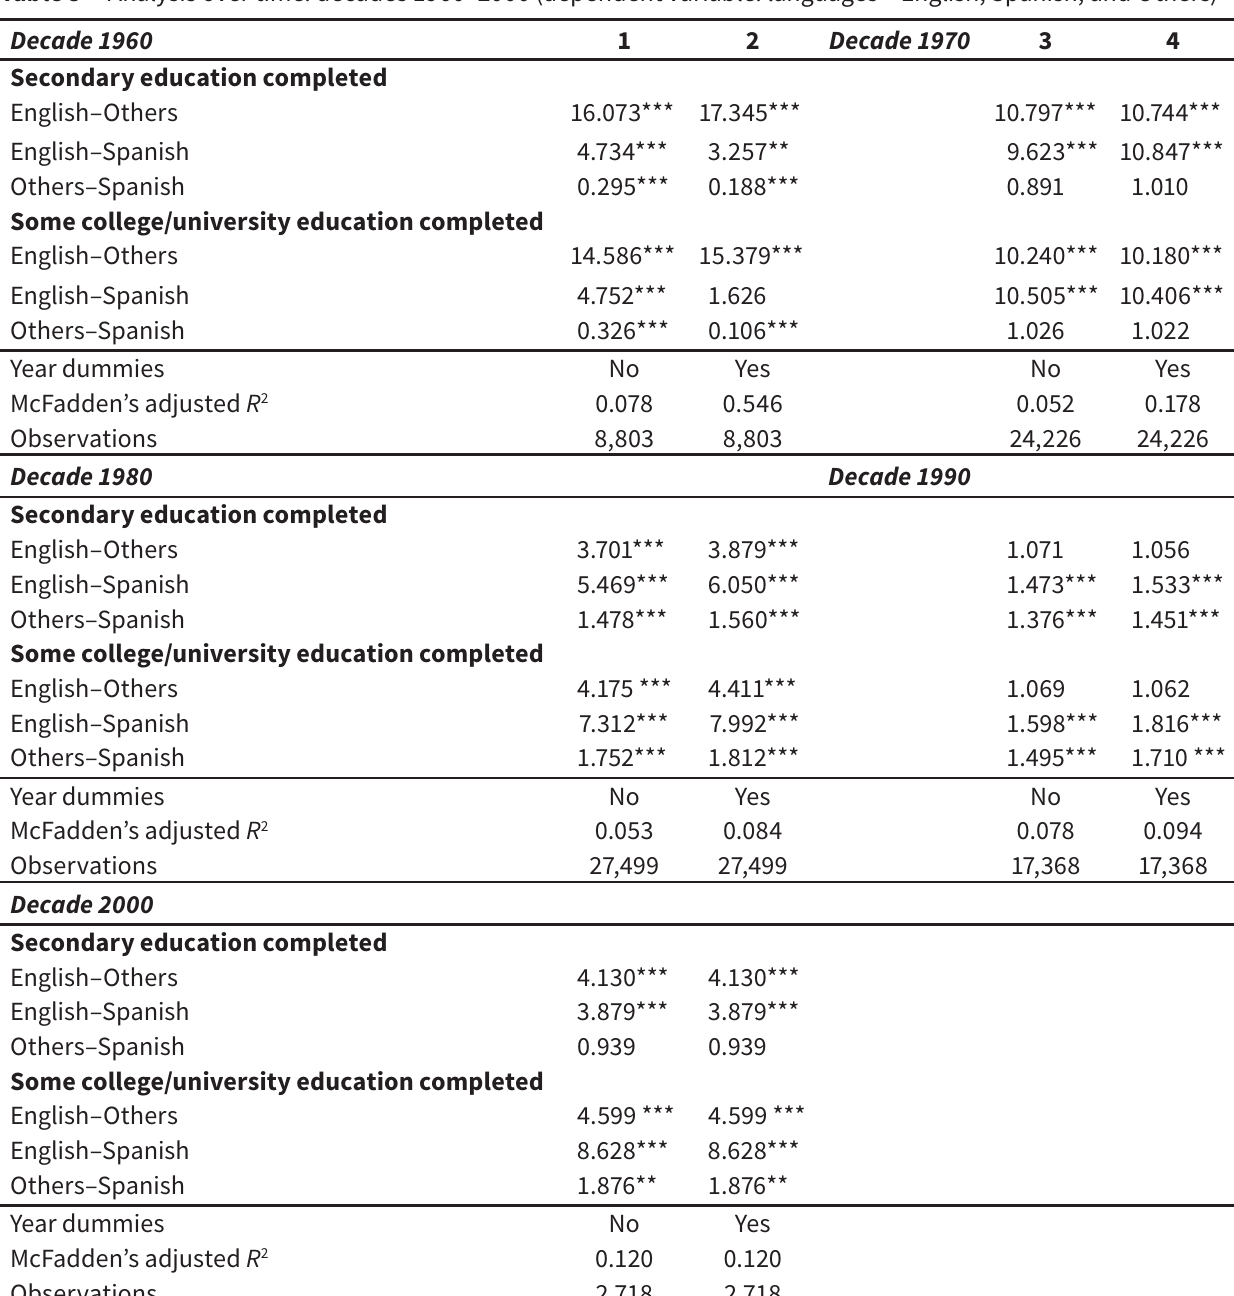
the destination countries. Languages are classified into the following categories: English, Spanish, and Others. This table shows the odds ratios, exp( b ) d , with d = 1. All columns include the following as controls: age, age i , m|n square/100, gender (male), being married, and being employed. Estimates are weighted. Standard errors are robust. *Significant at the 10%